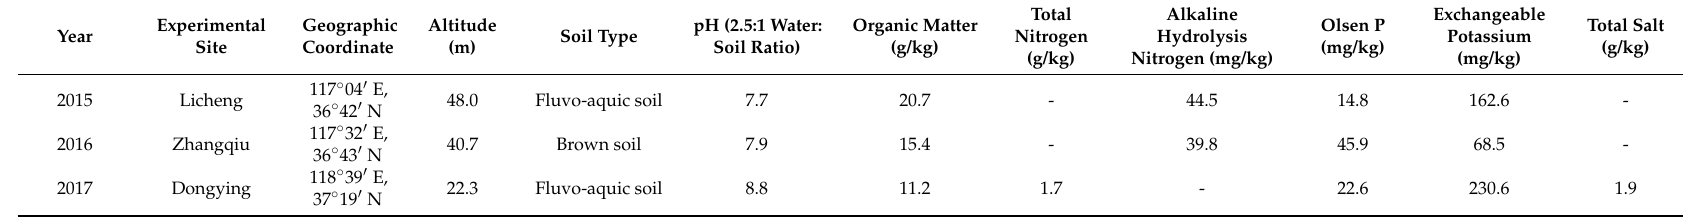
Table 1. Detailed site locations (geographic coordinates) and soil basal properties in the 0–20 cm soil